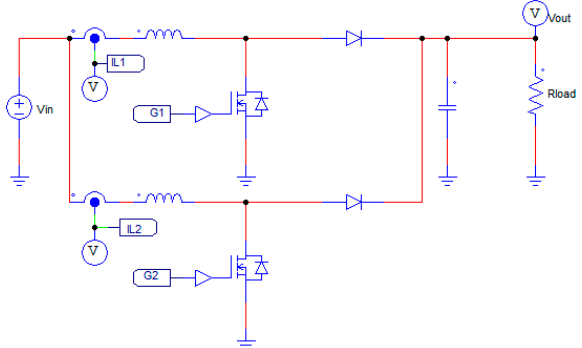
Figure 9. Two-phase boost converter.